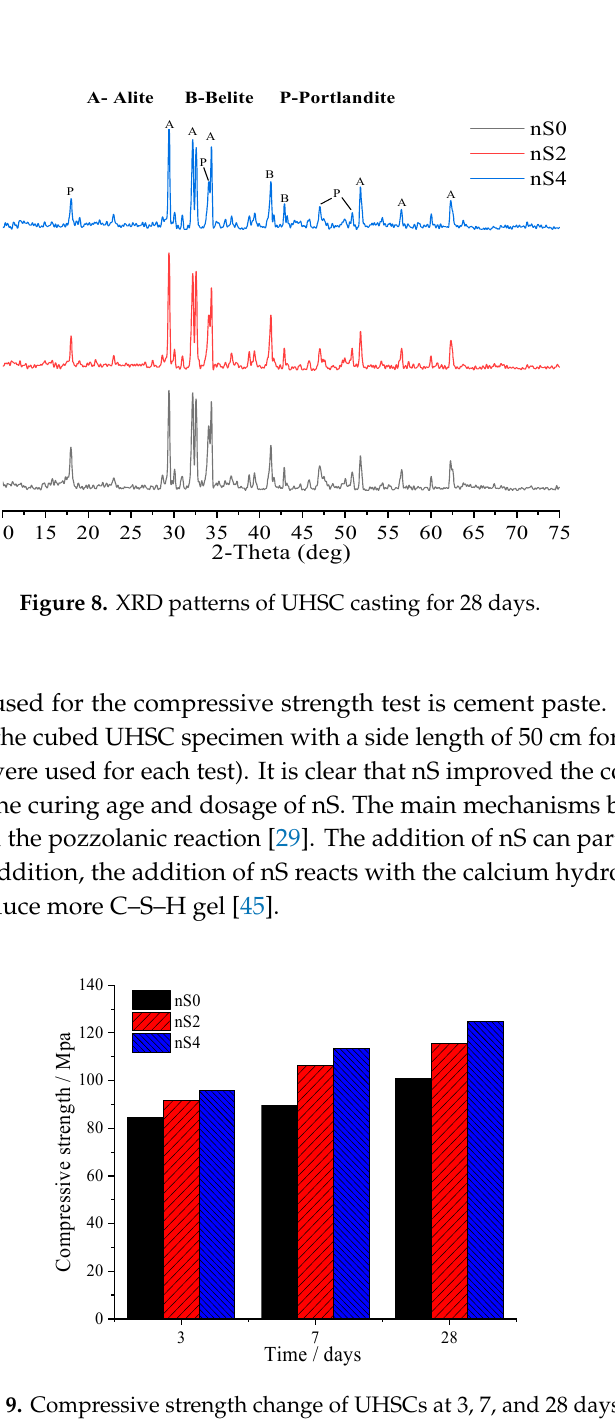
Figure 9. Compressive strength change of UHSCs at 3, 7, and 28 days.